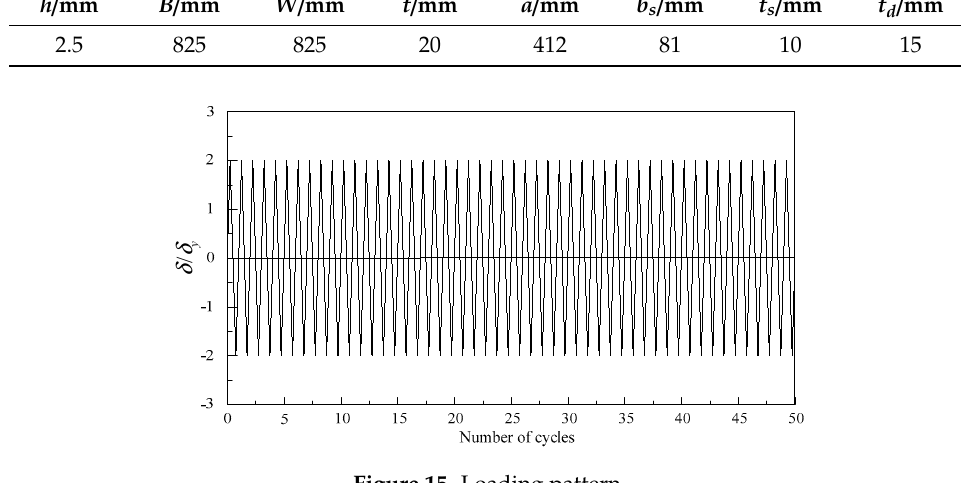
Figure 15. Loading pattern.